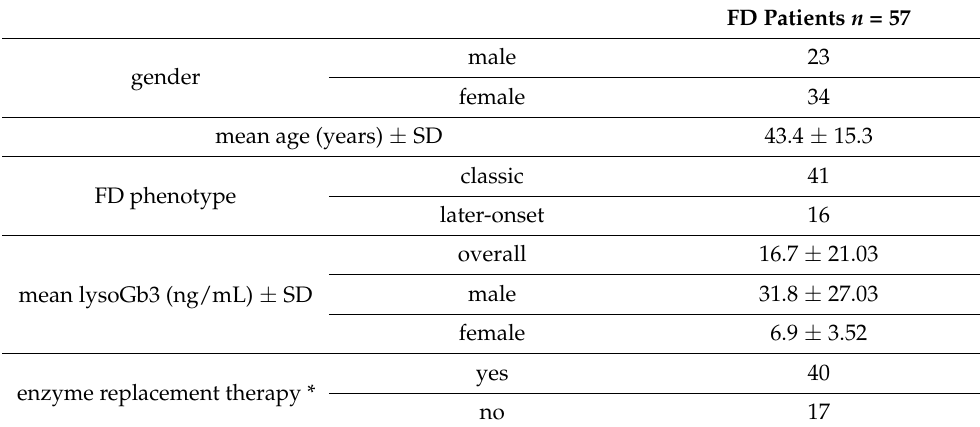
Table 1. Demographics and clinical characteristics of Fabry disease (FD) patients.